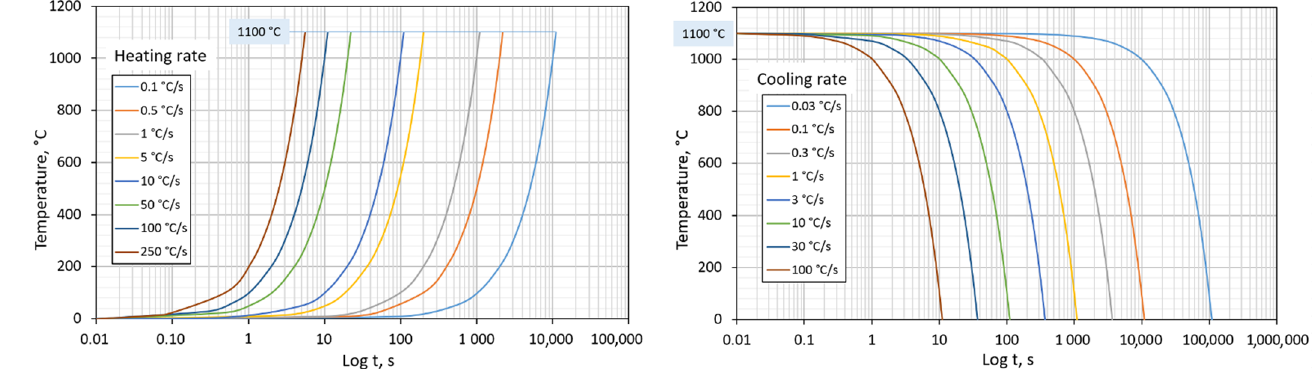
Figure 3. Different program temperature cycles for the control dilatometer DIL 805L; left —heating phase; right —cooling phase.